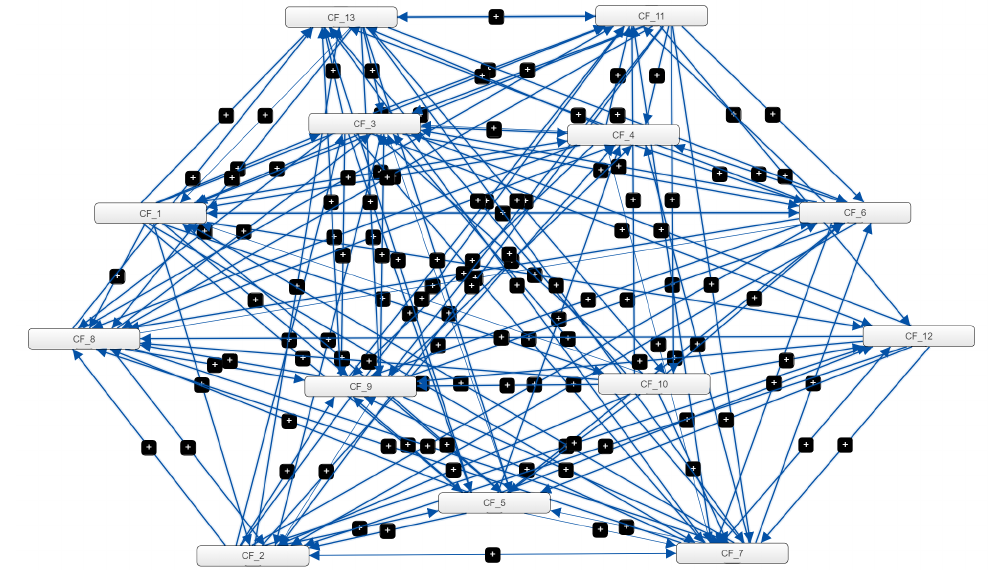
Figure 3. FCM displaying relationships among critical factors (update of Ref.